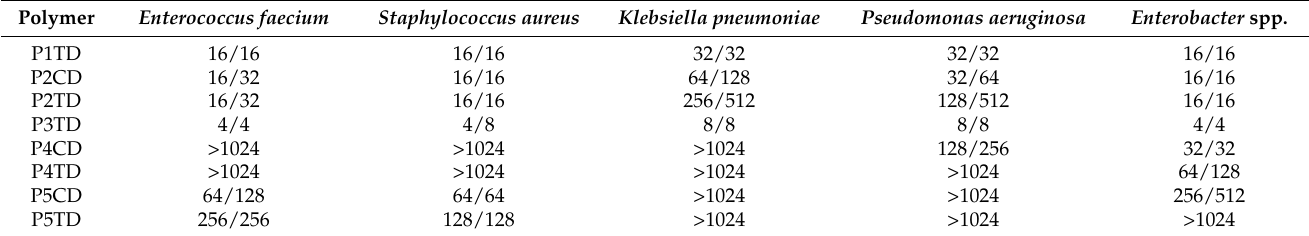
Table 3. Antibacterial activity of polycationic polymers MIC/MBC ( µ